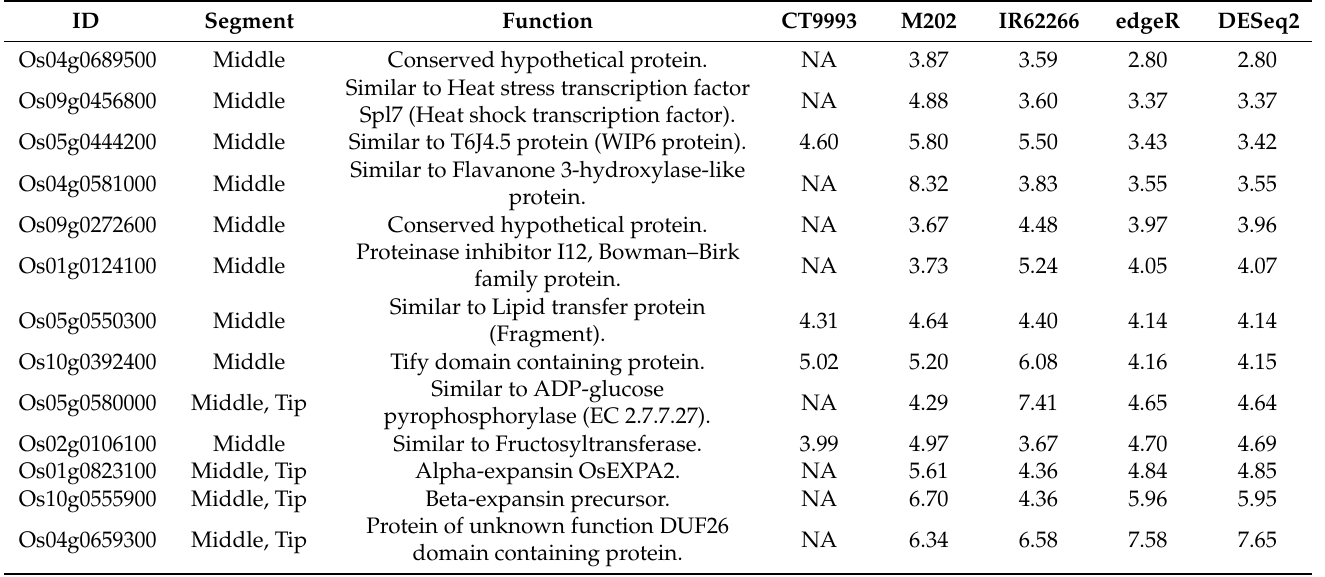
Table 5. Overlap of significant differentially expressed genes and respective log 2 fold changes in at least two out of three HNT-sensitive rice cultivars included in a whole leaf microarray analysis (CT9993, M202, IR62266) [22] and in the HNT-sensitive group used for the RNA-Seq analysis in this study (edgeR and DESeq2) including the leaf blade segments base, middle and